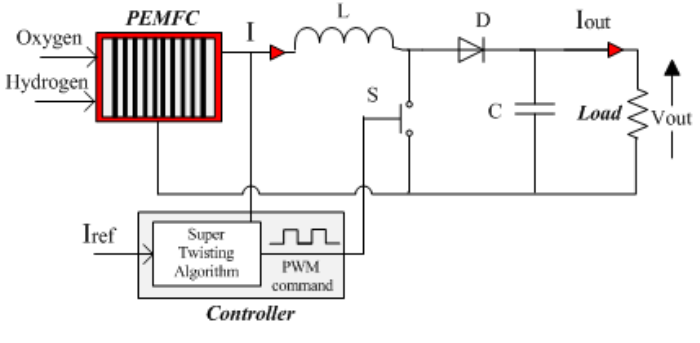
Figure 4. Synoptic diagram of a PEM fuel cell power